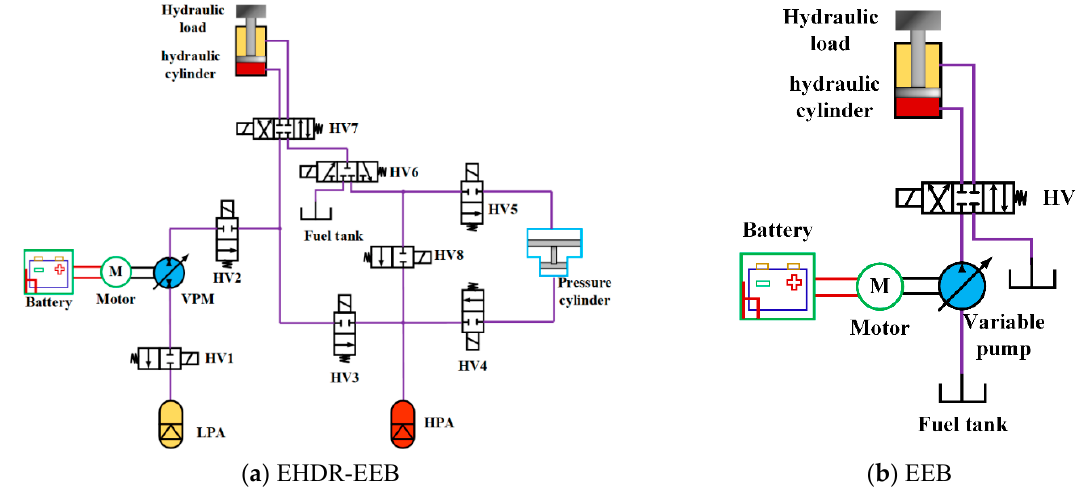
Figure 1. Structure diagram of the EHDR-EEB and EEB: ( a ) EHDR-EEB; ( b ) EEB.